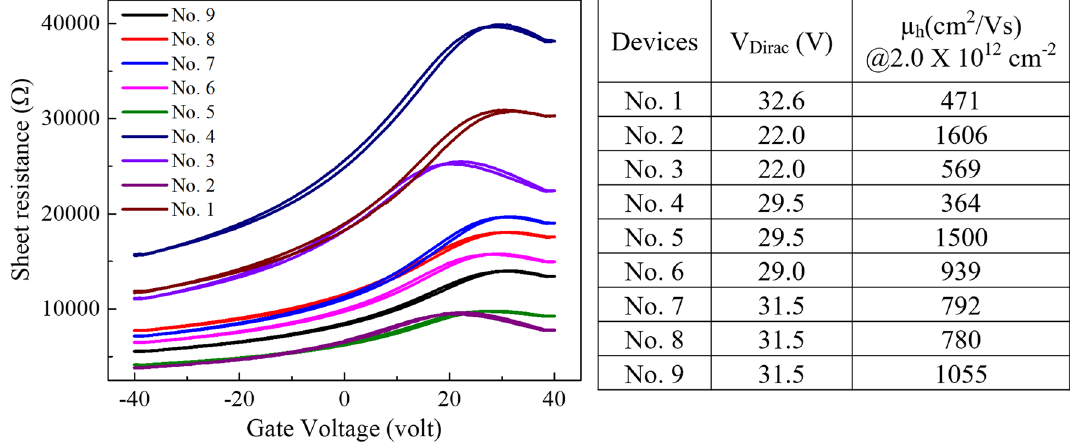
Figure 5. Characteristics of the fabricated graphene FET. The transfer characteristics curves of electronic resistance spanning a gate voltage from -40 to 40 V are shown for nine devices (left), along with the Dirac points and electron mobilities (right). The ratio of length to width for graphene channels was presumed to be 3, and n = 2.0 × 10 12 cm -2